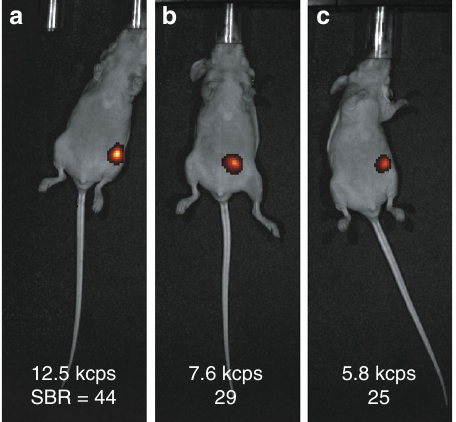
Fig. 6 Deep-tissue imaging of aUCNPs at low excitation intensity. Imaging of 12-nm core/shell NaEr 0.6 Yb 0.4 F 4 (8-nm core wth 2-nm shell) aUCNPs injected into mammary fat pads 3 – 4 mm below the skin at a 2 h, b 4 h, and c 6 h after injection. Laser intensity is 0.1 W cm − 2 focused at or near the injection site, and emission is from the Er 3 + 4 S 3/2 band (530 – 550 nm). SBR: signal-to-background